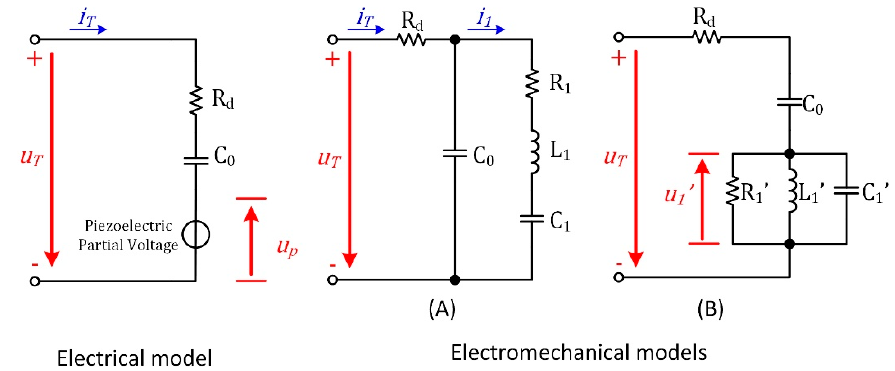
Figure 1. Electrical and Electromechanical models of high-power piezoelectric systems (HPPSs).